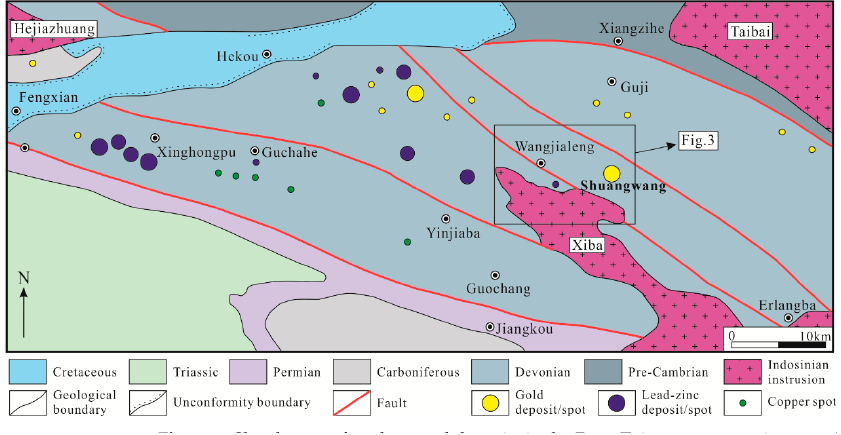
Figure 2. Sketch map of geology and deposits in the Feng-Tai ore concentration area (modified after [18,19]).